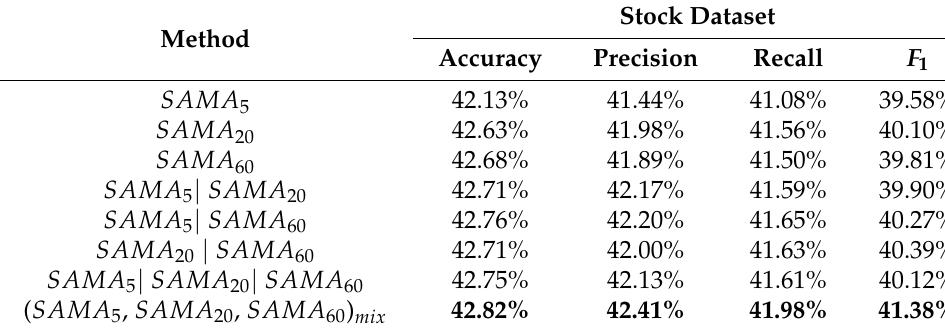
Table 2. Performance of multi-scale SAMA indicator fusion (stock dataset).